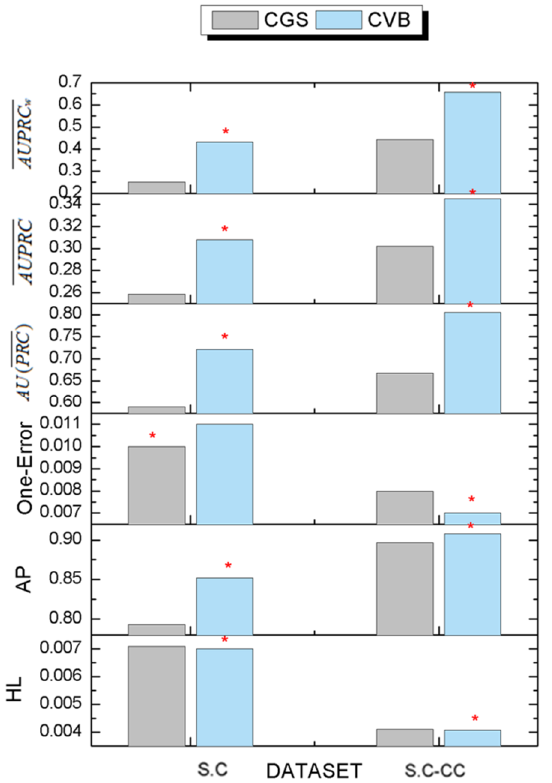
Figure 6. The comparison results with CVB0 and CGS. The red asterisk represents the best results in each dataset.